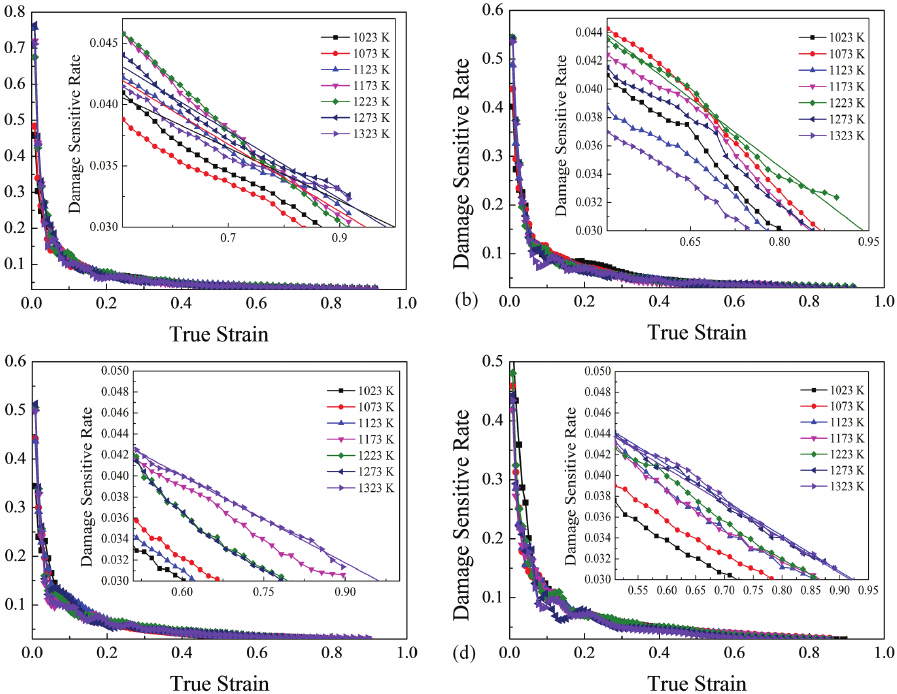
Figure 7: The variation of damage sensitive rate under different temperatures and strain rates (a) 0.01 s − 1 , (b) 0.1 s − 1 , (c) 1 s − 1 , (d) 10 s − 1 .